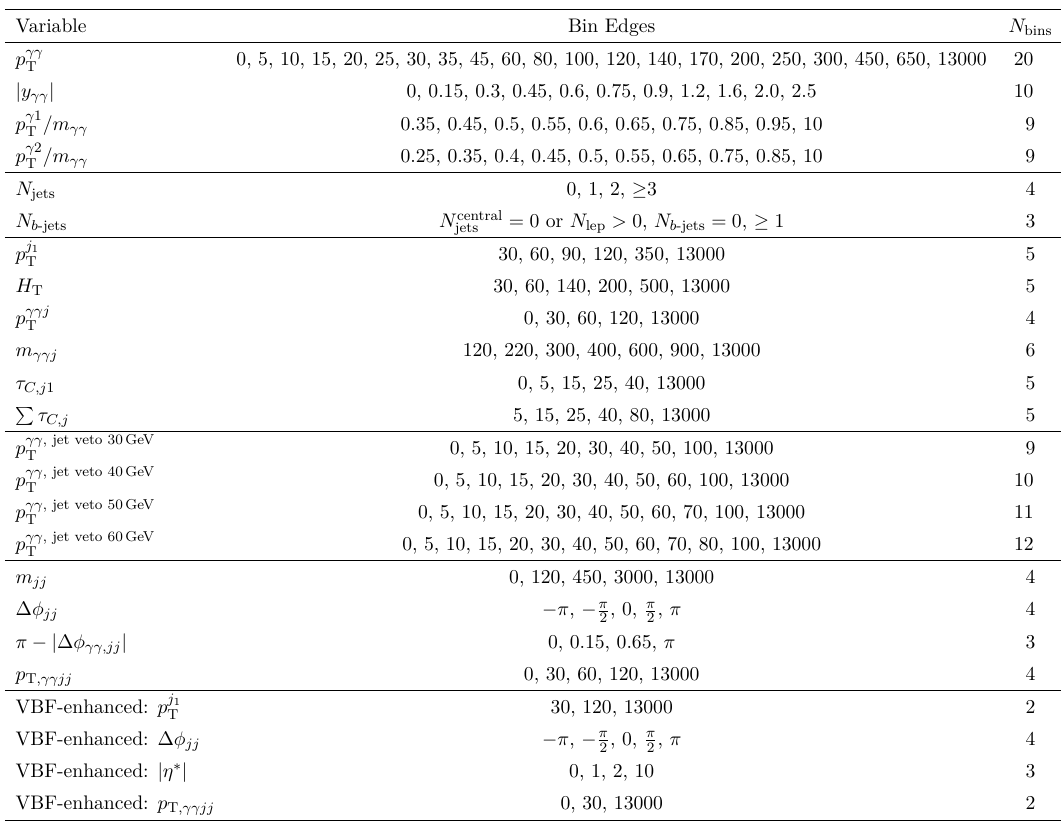
Table 1. Bin ranges for the differential cross-section measurements. Transverse momenta, invariant masses and the H and τ variables (defined in the text) are given in GeV. For the jet multiplicities, T the values reported in the table are the definition of the